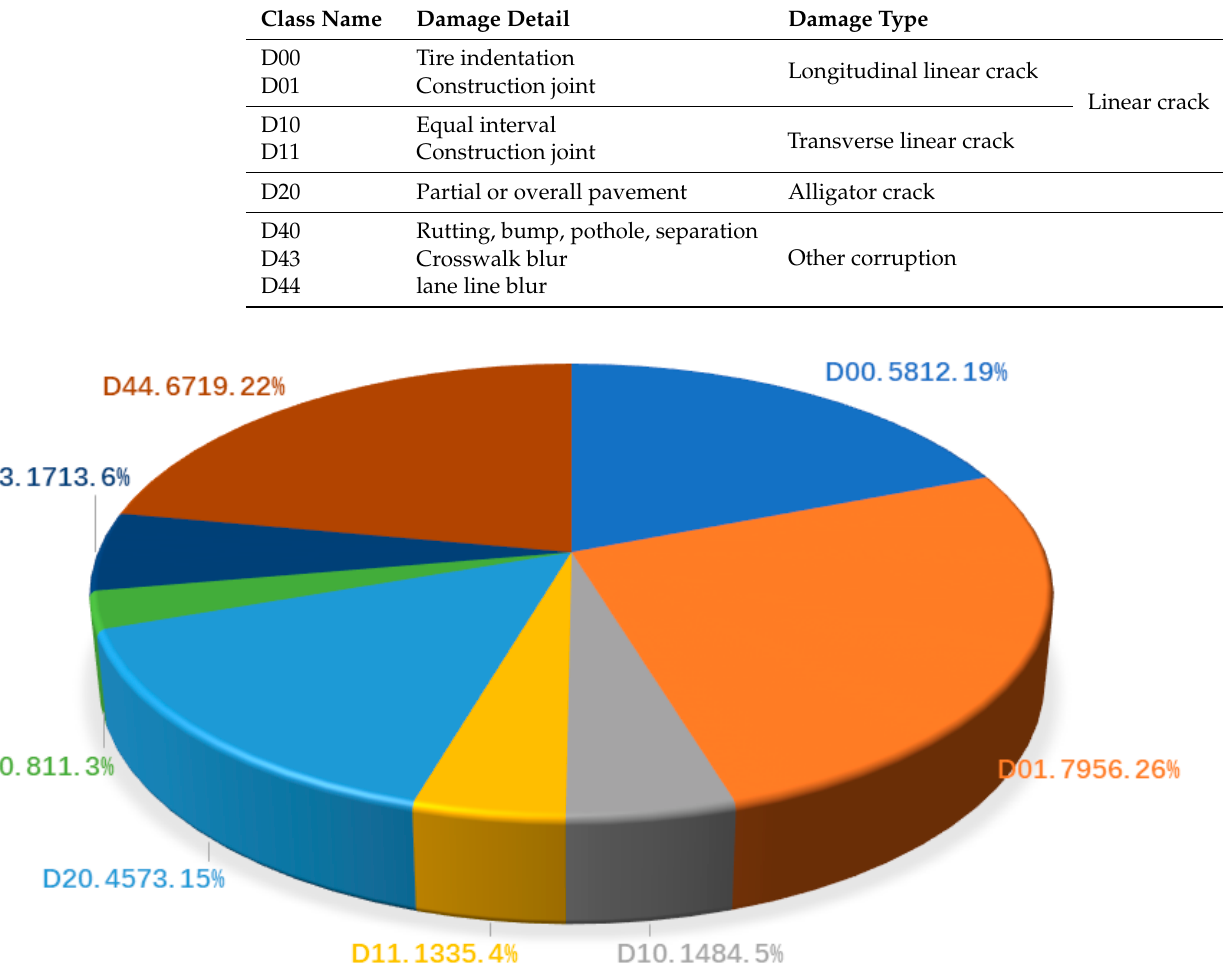
Table 5. Eight categories of road damage and their definitions in the GRDDC’2020 dataset.